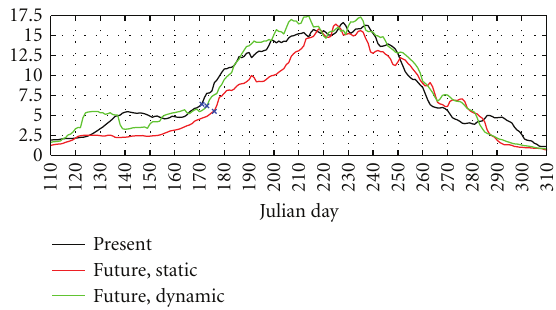
Figure 6: 11-day running mean of the zonally averaged daily pre- cipitation (mm) at 10 ◦ N, with the monsoon onset approximately marked by “x”.